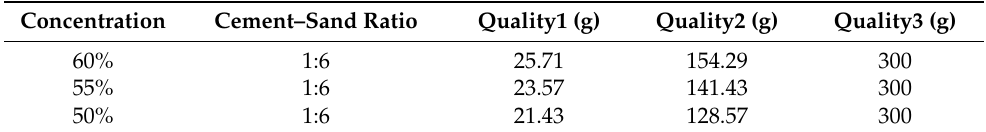
Table 5. Tailings test scheme parameters.